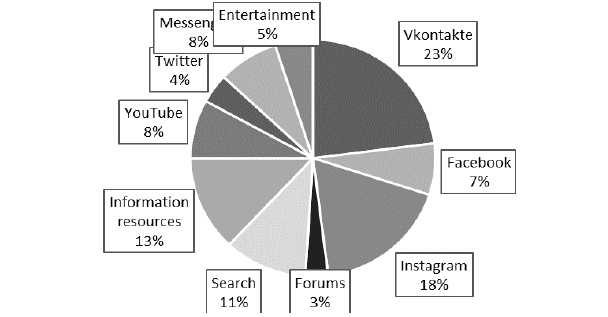
Figure 2. Rating of popularity of Internet resources among generation